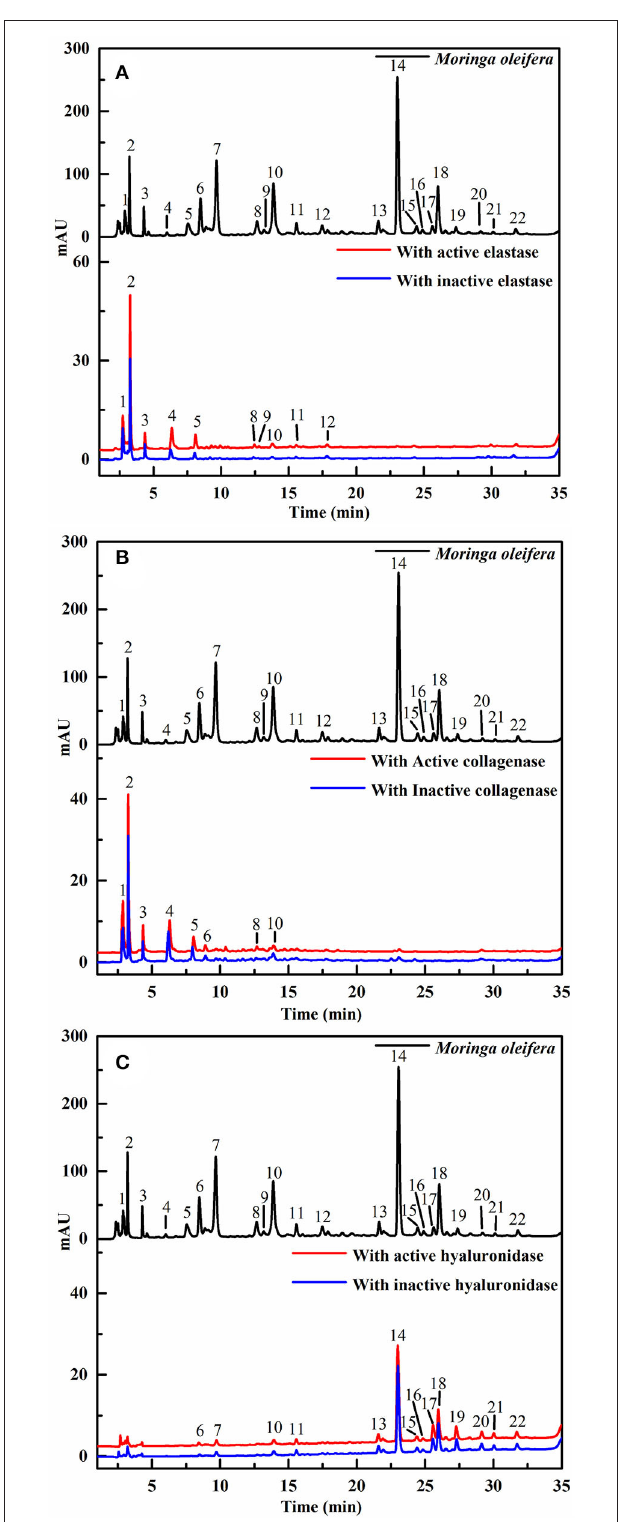
FIGURE 2 | The high-performance liquid chromatography (HPLC) profiles of the chemical components in M. oleifera were monitored after affinity